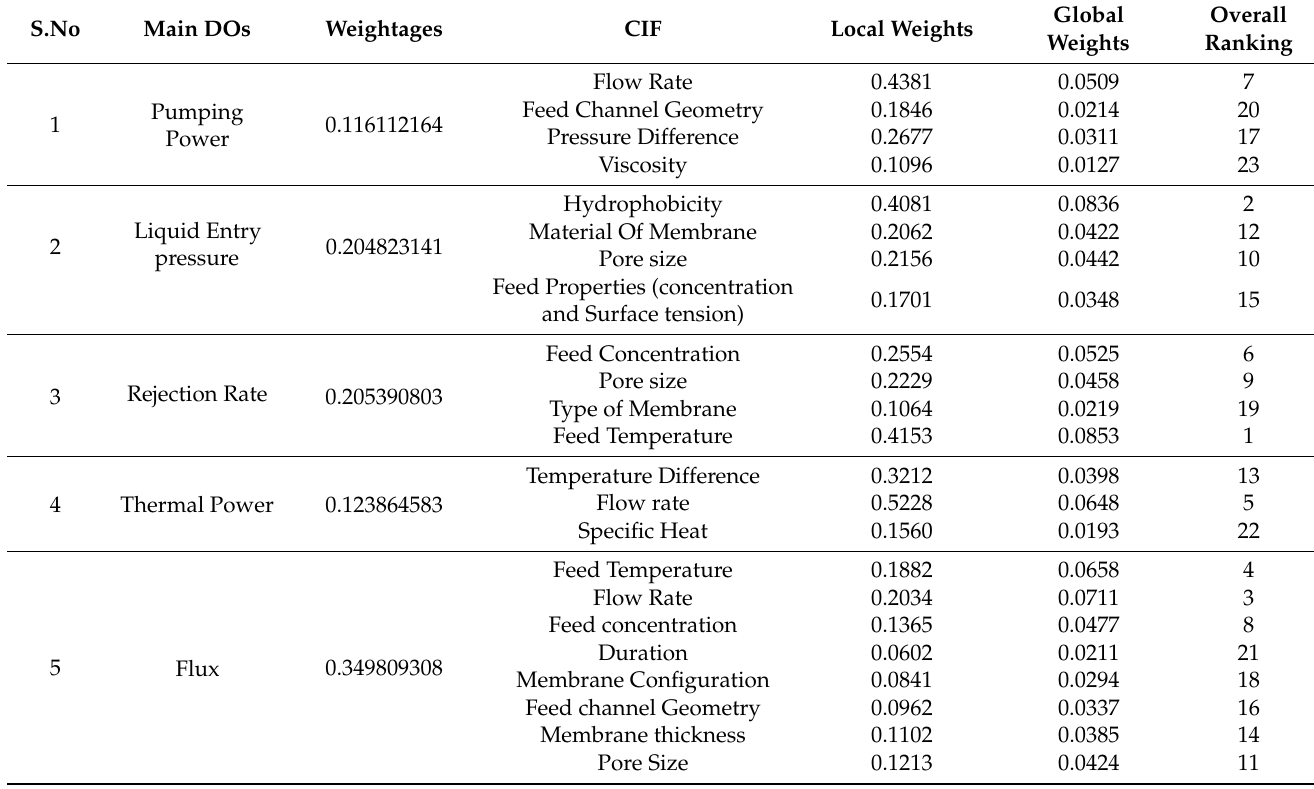
Table 6. Composite weightages of CIFs of MD by using